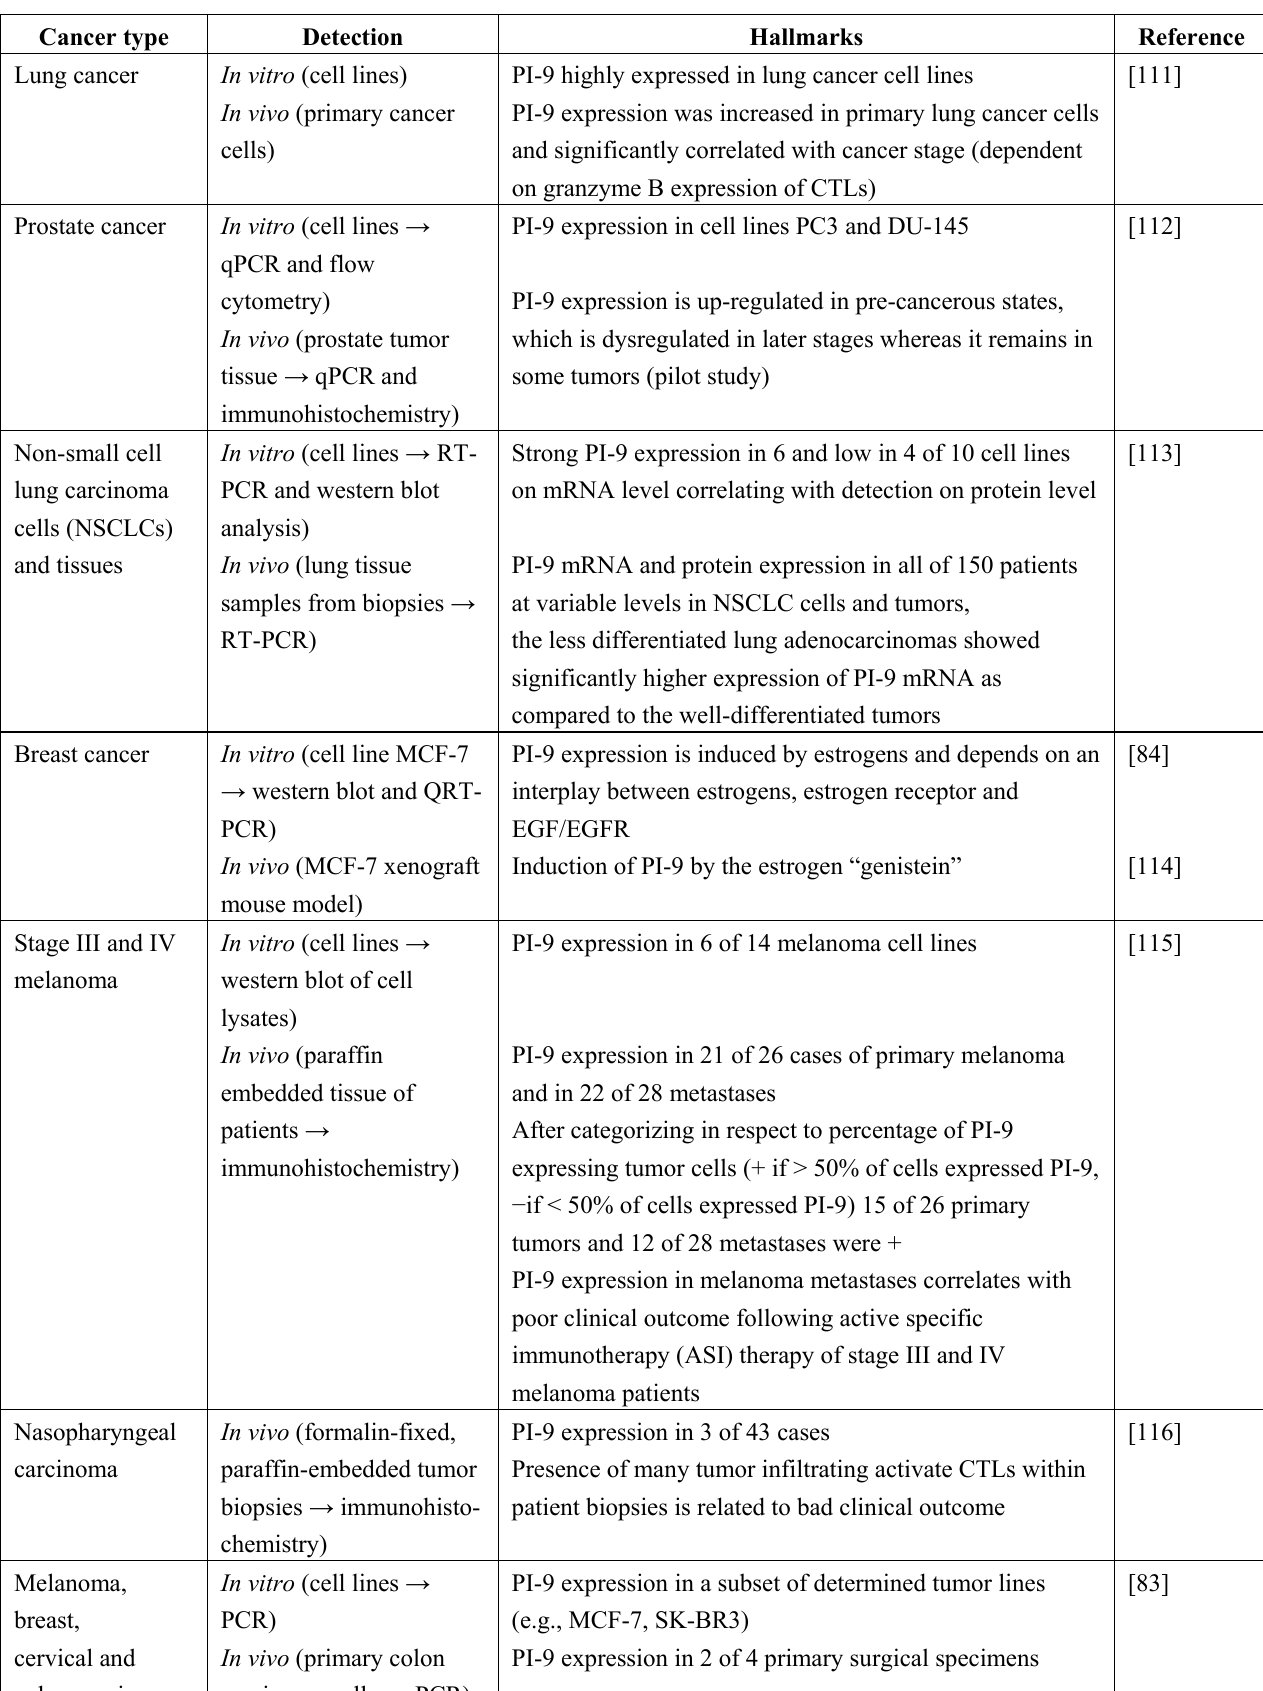
Table 3. Overview of PI-9 expression in different carcinomas / melanomas. Cancer